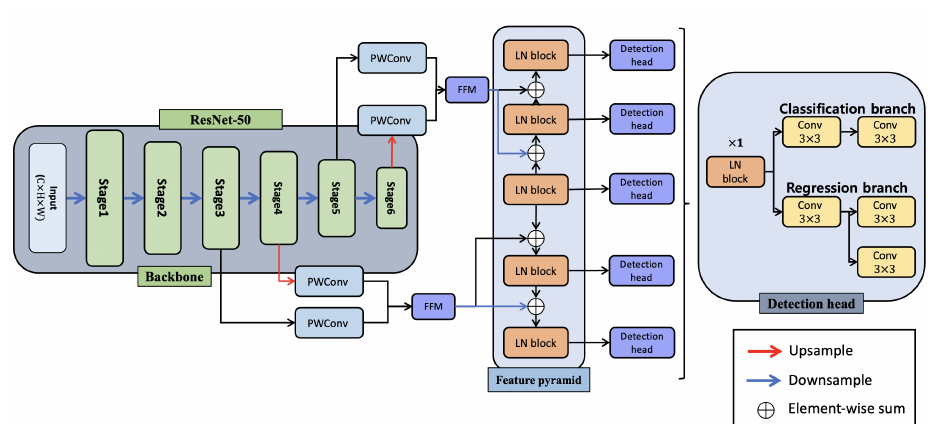
Figure 4. Structure of the proposed light next fully convolutional one-stage detector (LNFCOS). The proposed method replaces the existing 3 × 3 StdConv and improves spatial information by reconstructing a feature pyramid based on LNblock. In addition, based on the proposed feature fusion module, the feature information was improved with a minimum computational cost. Finally, based on the proposed LNblock, the structure of the detection head was improved to reduce the computational cost.